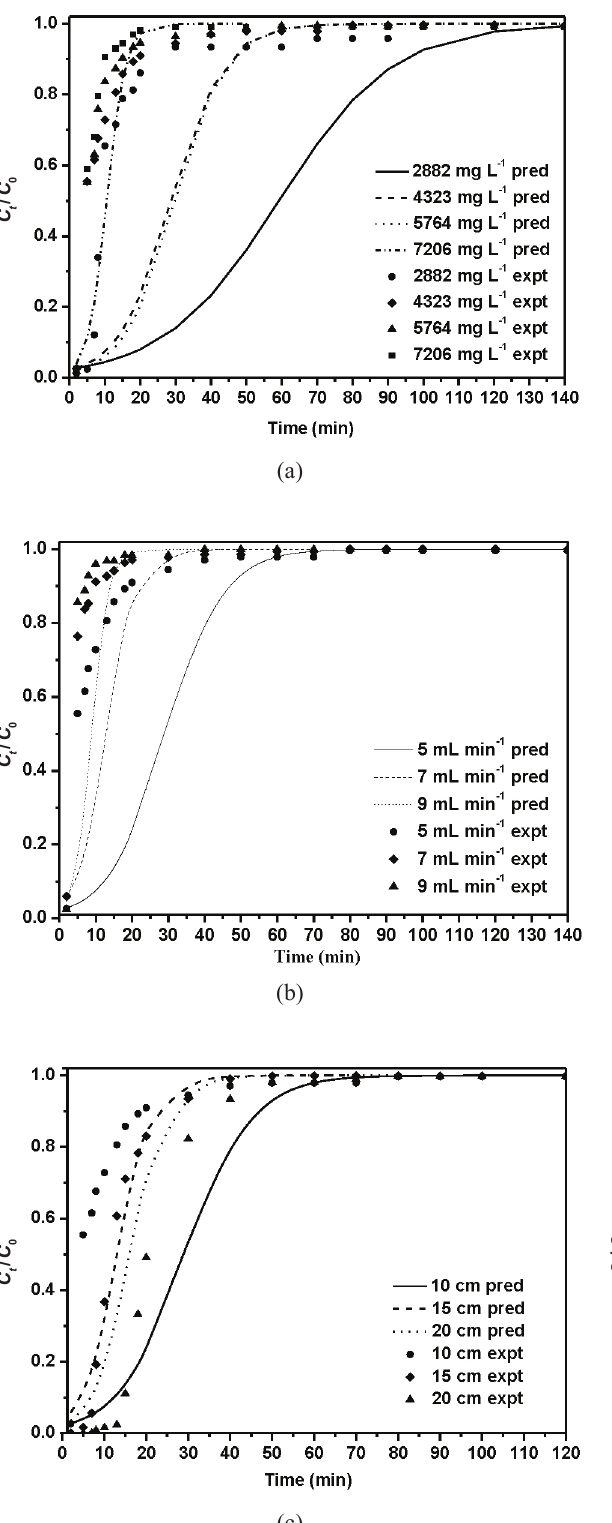
Fig. 8 – Comparison of experimental and predicted break- through curves using deactivation kinetic model at different (a) influent concentrations, (b) flow rates, and (c) bed